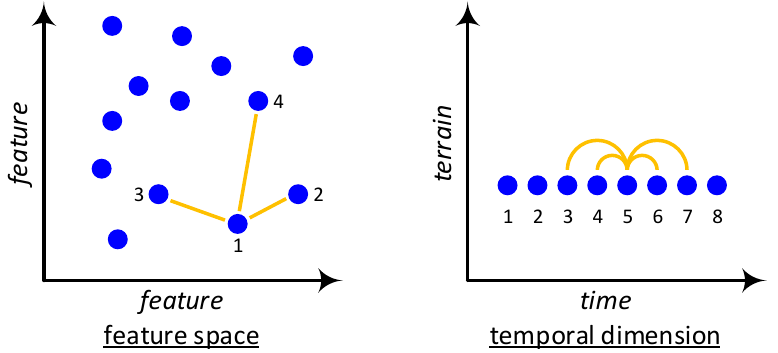
Figure 2. Illustration of establishment of similarity matrix. As the left subfigure shows, N 1 ( x 1 ) = { x } and w ( 1 ) > w ( 1 ) > w ( 1 ) under k = 3. As the right subfigure shows, N 1 ( x 5 ) = 2 , x 3 , x 3 1,2 1,3 1,4 { x } and w ( 2 ) = w ( 2 ) > w ( 2 ) = w ( 2 ) under k = 3 , x 4 , x 6 , x 7 5,6 5,2 5,7 5,4